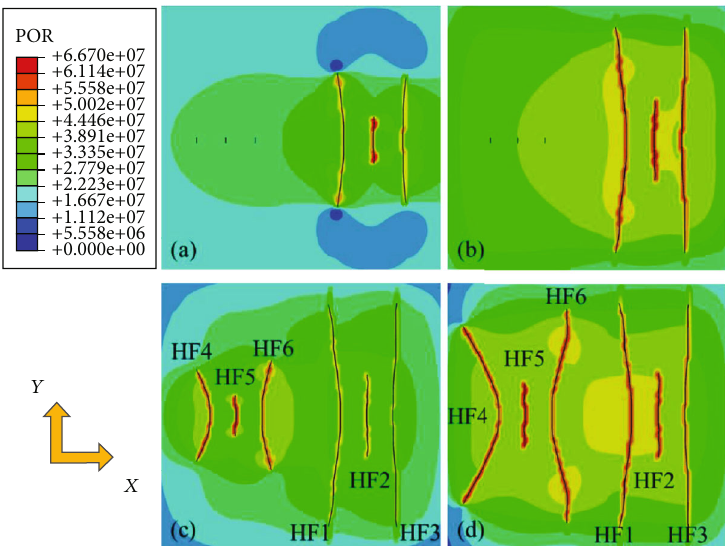
Figure 13: Fracturing propagation results between di ff erent stages: (a) fracturing in the fi rst stage for 20mins, (b) fracturing in the fi rst stage for 40mins, (c) fracturing in the second stage for 20mins, and (d) fracturing in the second stage for 40